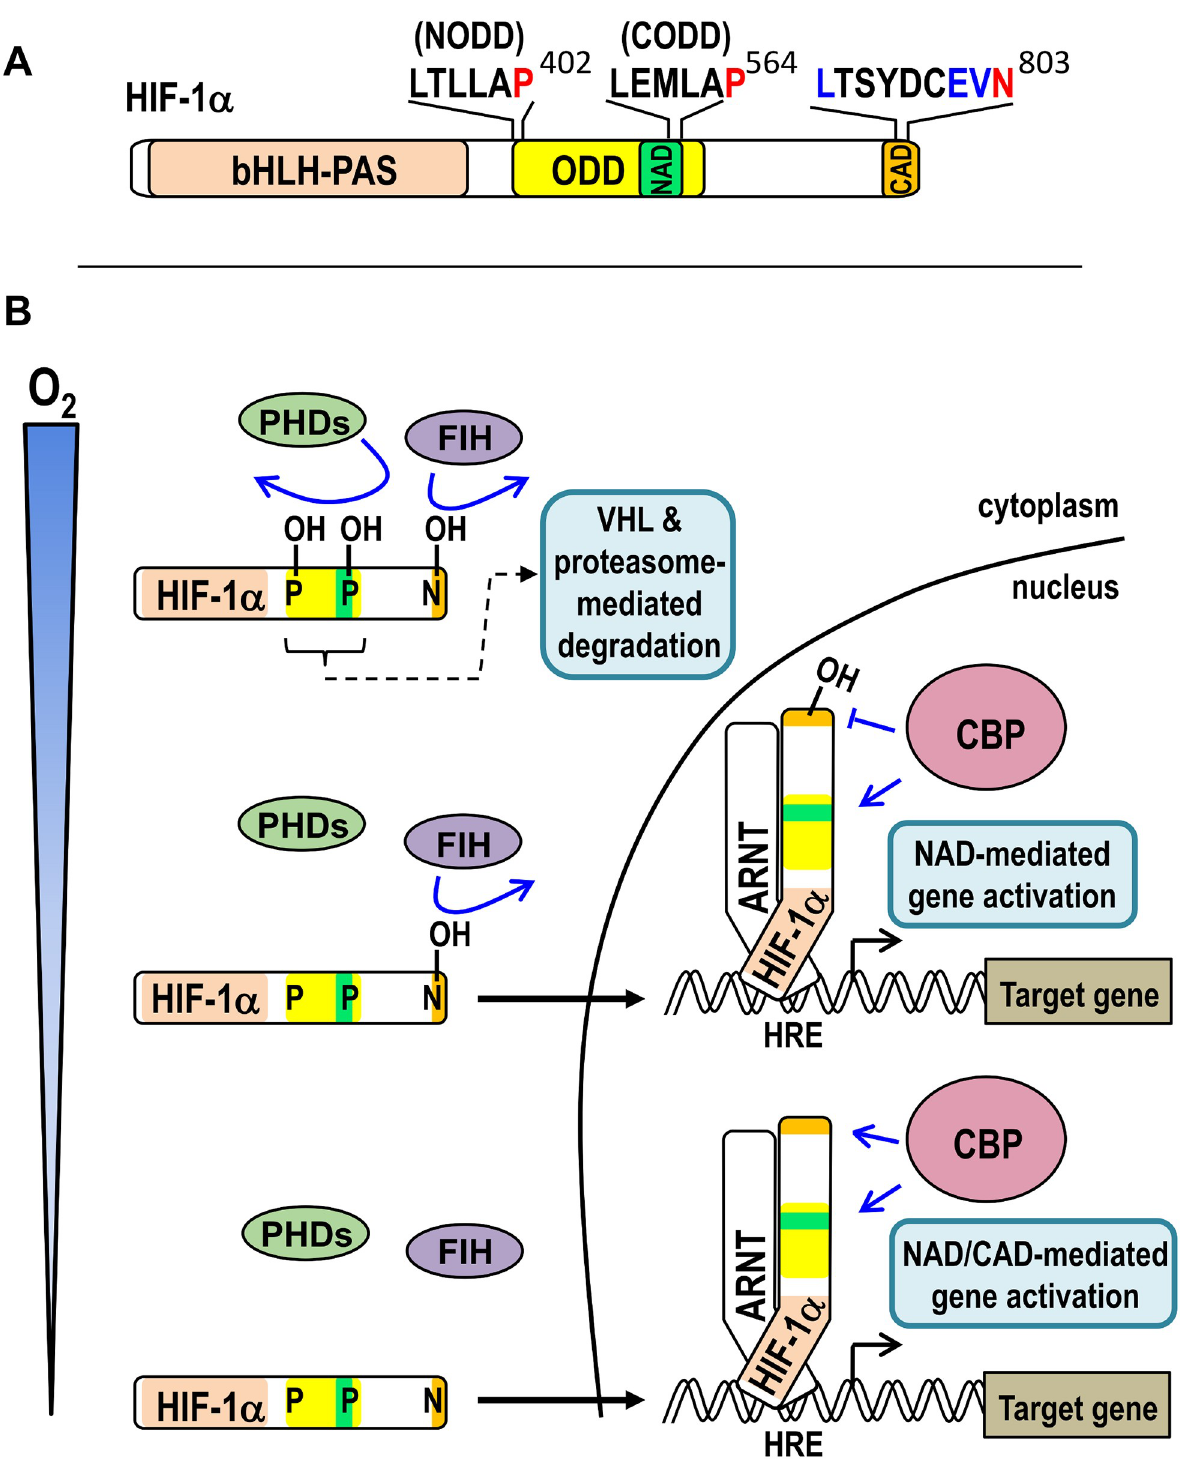
Fig 1. Activation of HIF-1 signalling by hypoxia. (A) Schematic of human HIF-1 α (hsHIF-1 α ) showing the regions involved in DNA-binding and dimerisation with ARNT (bHLH-PAS), oxygen-dependent degradation (ODD), and coactivator binding (the N- and C-terminal transactivation domains, NAD and CAD, respectively). The asparaginyl residue (Asn803) hydroxylated by FIH is shown in red with residues constituting the remainder of the “FIH preferred target sequence” shown in blue above the CAD. The PHD-targeted prolyl residues which are central to the N- and C-terminal ODDs (Pro402 (NODD) and Pro564 (CODD), respectively) are similarly indicated above the ODD. (B) Schematic showing the